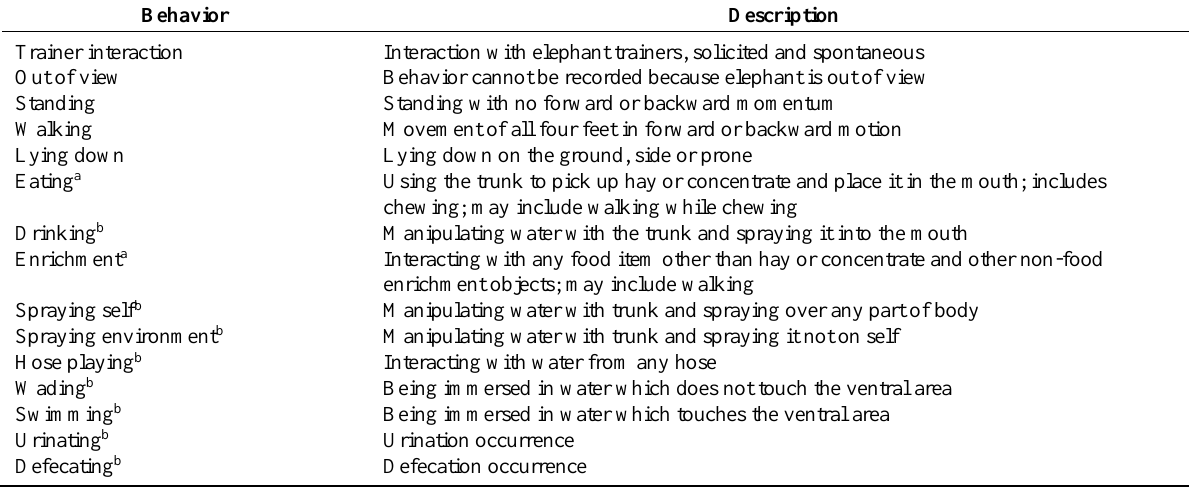
Ethogram Key of Mutually Exclusive Behaviors Recorded During Diurnal Observation Periods Behavior